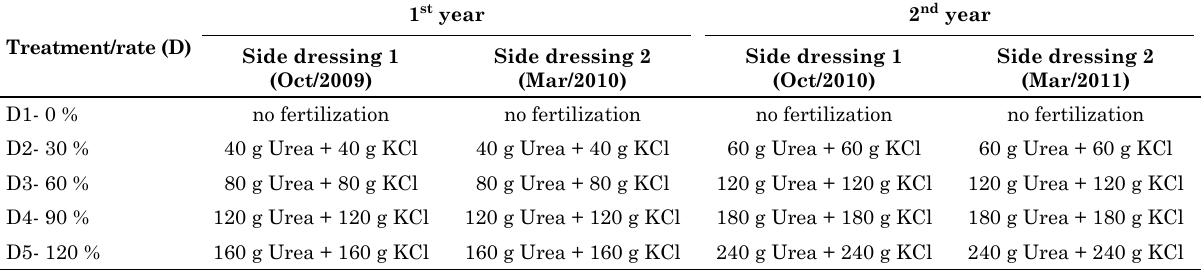
Table 2. Side-dressing of N and K per macaw palm tree grown for two years of cultivation, at the Experimental station of araponga, mg